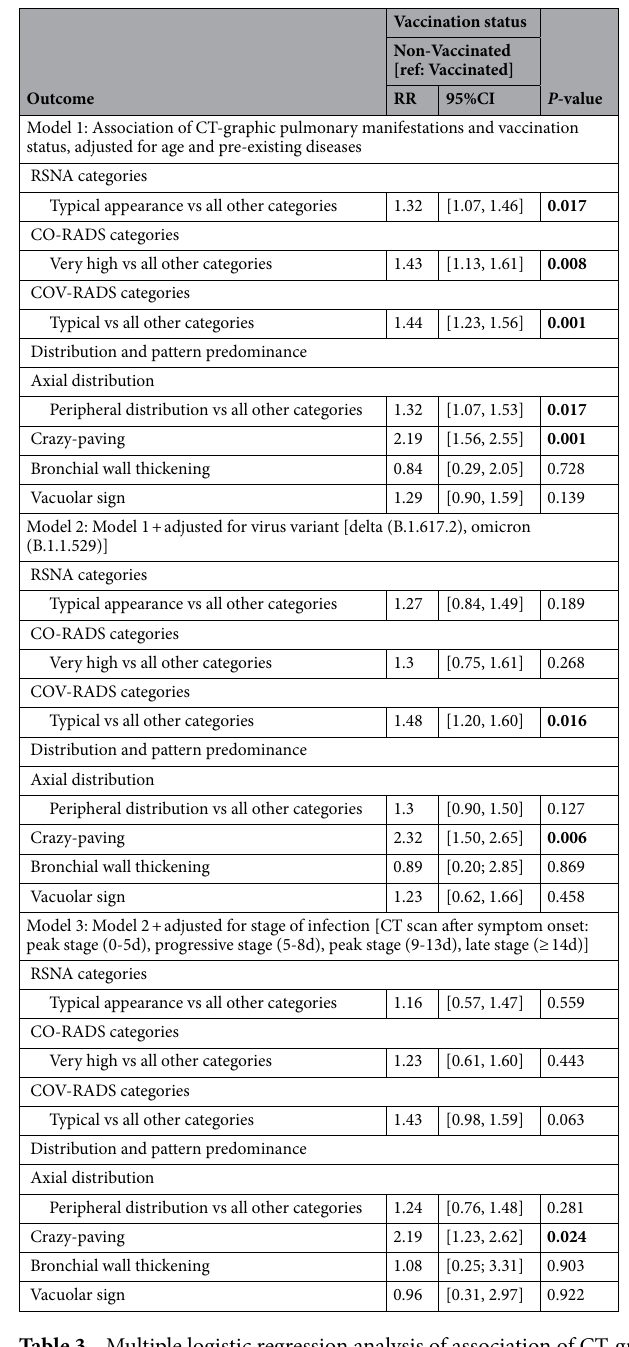
Table 3. Multiple logistic regression analysis of association of CT-graphic pulmonary manifestations and vaccination status. Results of a logistic regression model with outcome pulmonary changes and